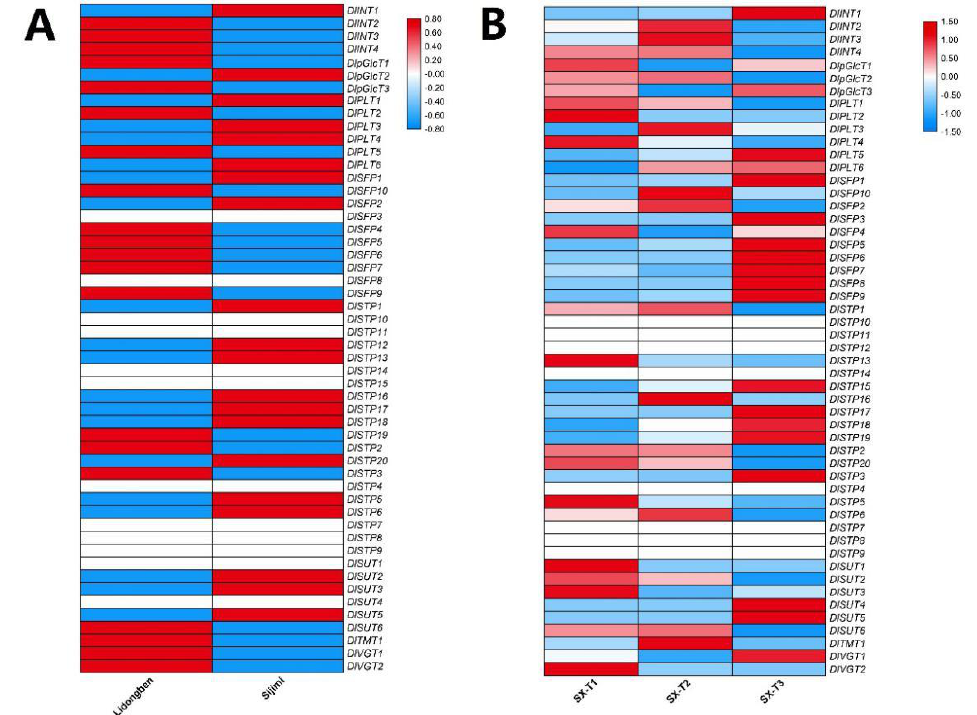
Figure 9. Expression profiles of the DlSTs in different varieties and tissues. ( A ) The expression profile of the DlST genes in ‘Lidongben’ and ‘Sijimi’. ( B ) The expression profile of the DlST genes in different floral bud development stages in ‘Shixia’. SX-T1 represent stage before the emergence of floral primordia, SX-T2 represent stage of the appearance of red dot, and SX-T3 represent stage of the appearance of the first inflorescence apical buds. The color scale represents the log2 (expression values + 1); the red and blue colors indicate the higher or lower expression level, respectively.